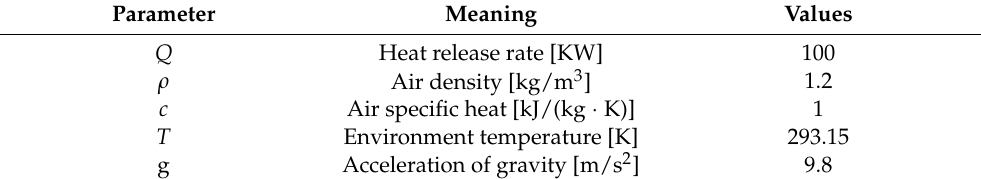
Table 2. Parameter table.